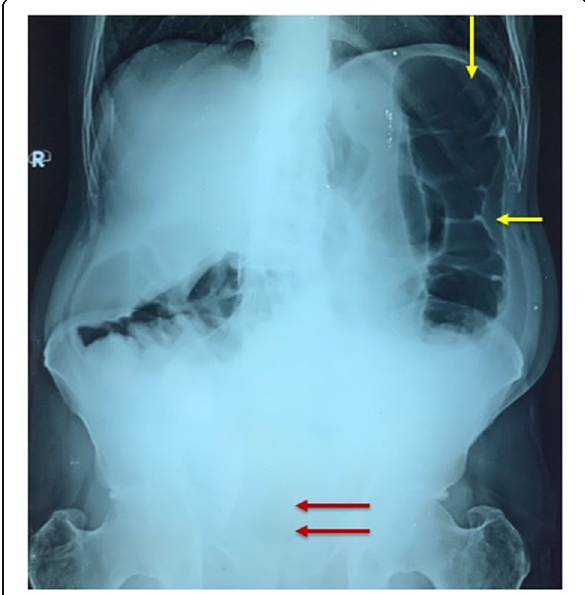
Fig. 2 X-ray abdomen erect AP view image showing decending colon and splenic flexure of colon is grossly dilated (yellow arrows), and there is no rectal gas shadow is seen (red